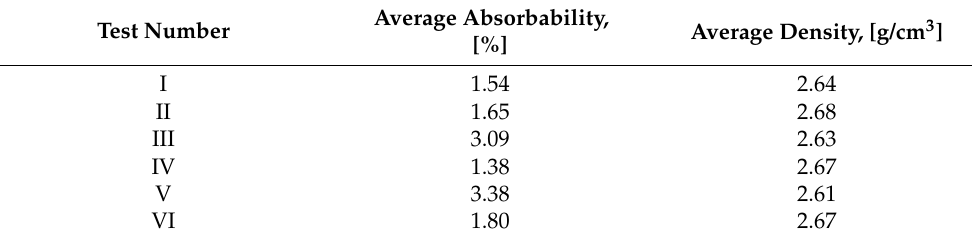
Table 6. Average values of absorbability and density for individual tests.